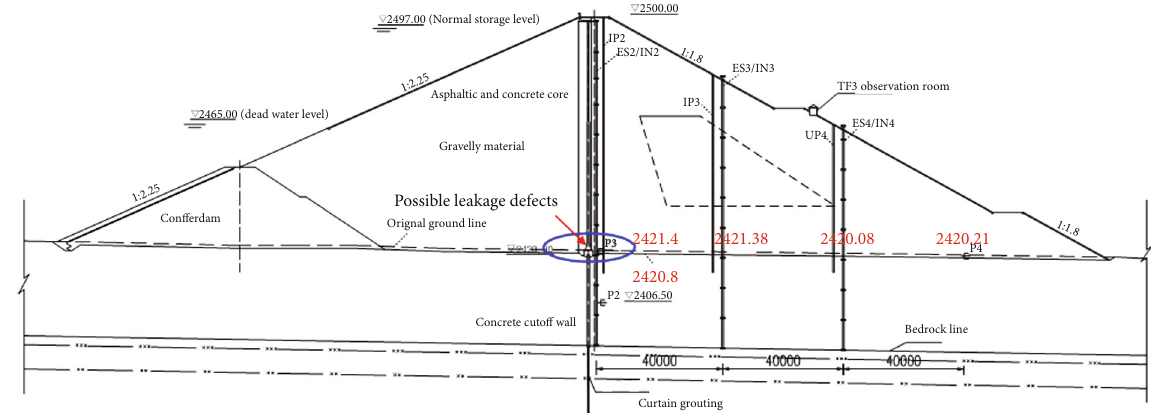
Figure 19: The distribution map of water level in the cross section 0 + 290 .